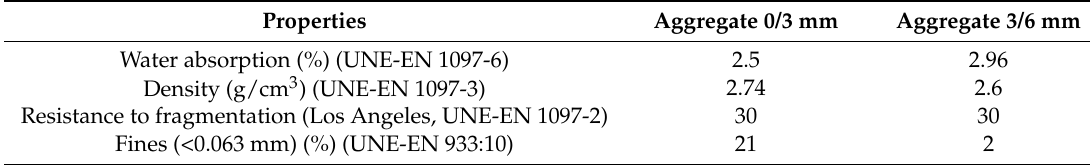
Table 4. Results recycled aggregates physical properties.